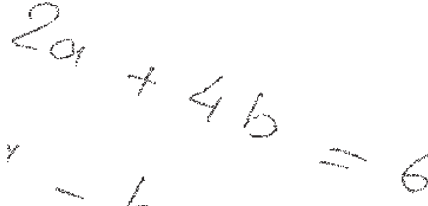
Figure 9: Equation area recognition.